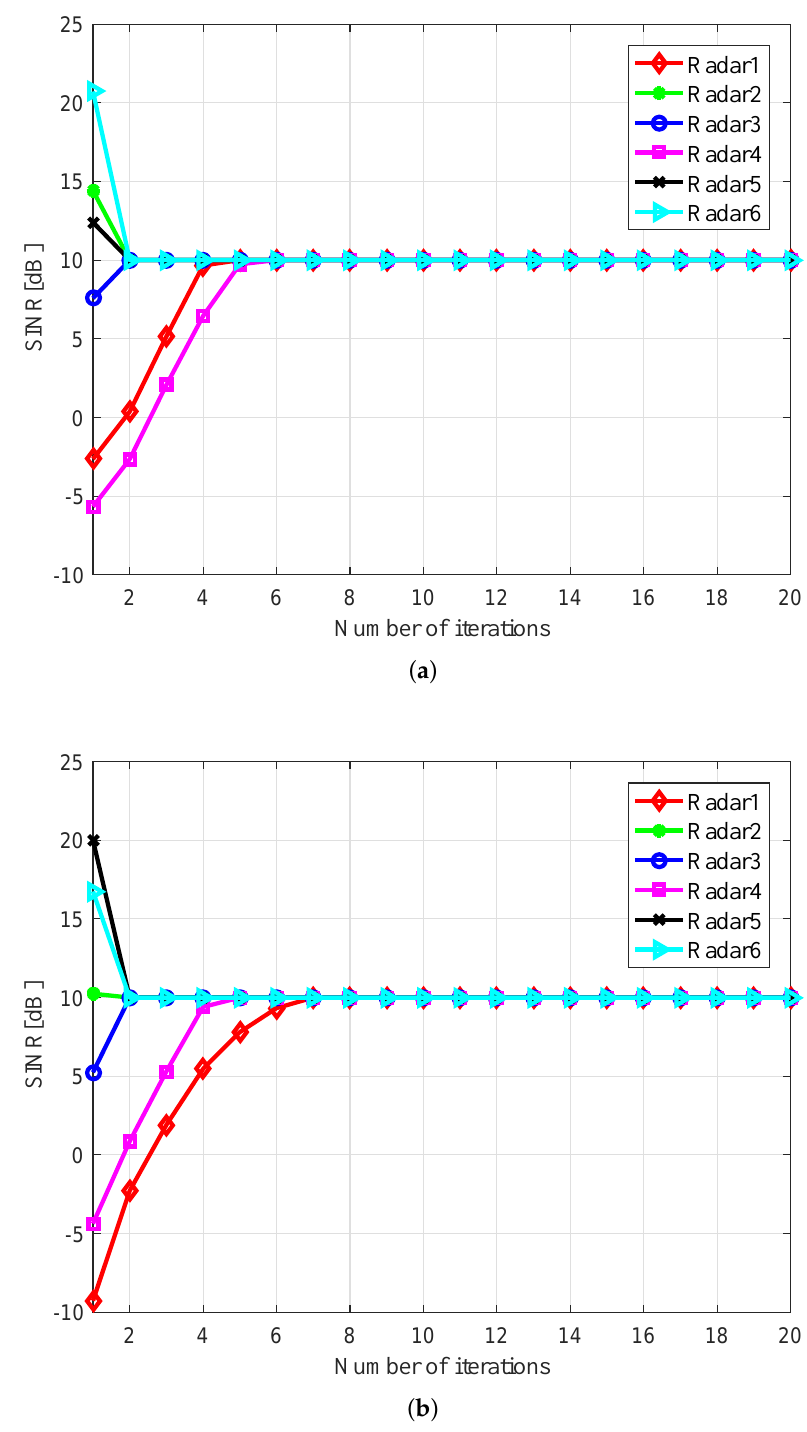
Figure 7. Convergence behavior for the achieved SINR of each radar in the second case: ( a ) Target position is [ 0,0 ] km; ( b ) Target position is [ − 30, − 40 ]